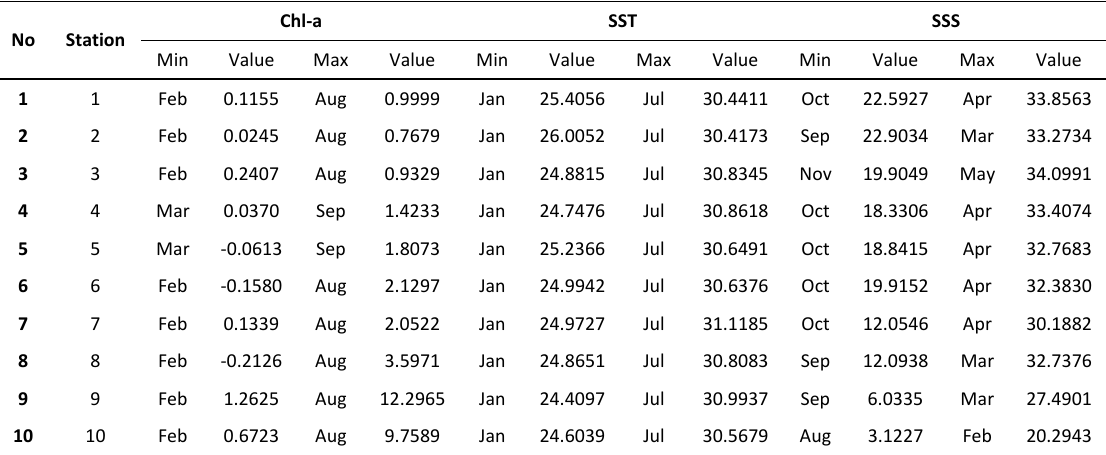
Table 3: Peaks and troughs for the seasonal model